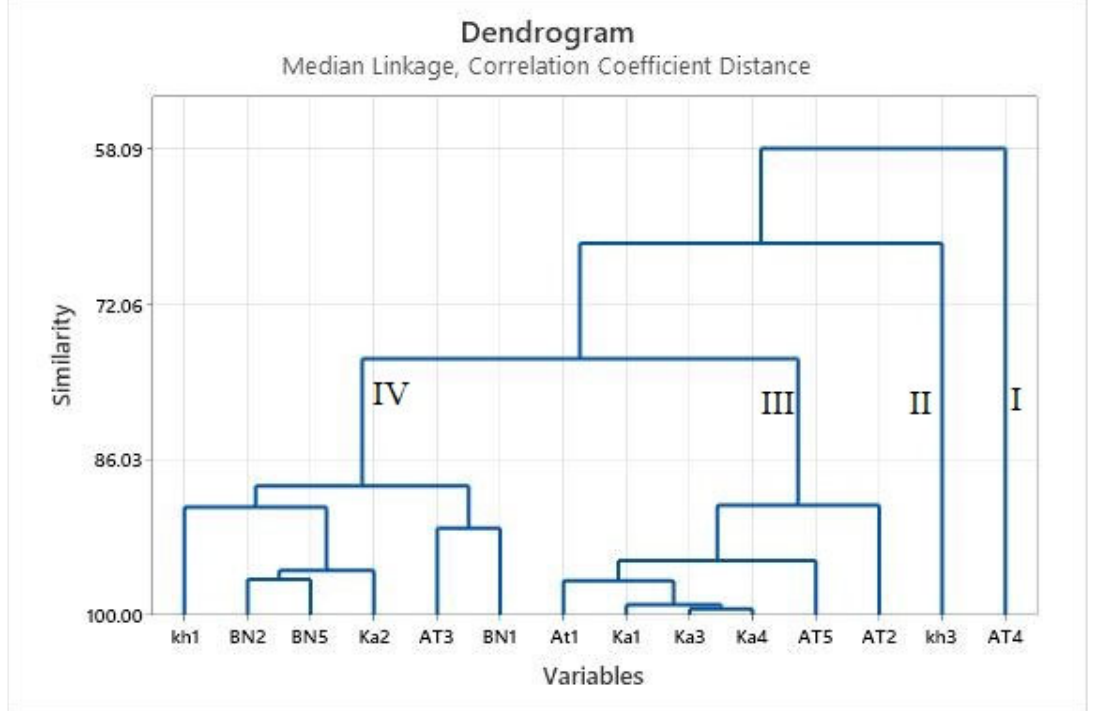
Figure 1. Cluster analysis of 14 superior myrtle accessions from southern Iran under greenhouse conditions. This analysis based on their major essential oil (EO) composition using Median Linkage method. The myrtle accessions were classified into 4 groups based on the main EO components, including I: caryophyllene oxide/germacrene D/ α‐ humulene/methyl eugenol chemotype; II: α‐ pi ‐ nene/ p ‐ cymene/ α‐ humulene and ( E ) ‐β‐ caryophyllene; III: α‐ pinene/1,8 ‐ cineole, and linalool; IV: li ‐ nalyl acetate/ γ‐ terpinene/1,8 ‐ cineole/limonene.